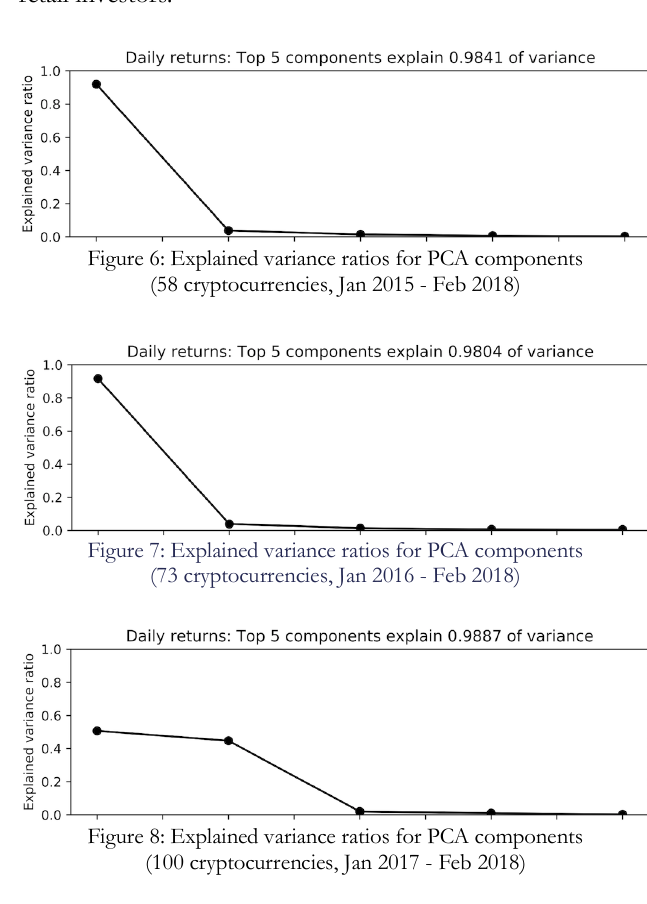
Figure 8: Explained variance ratios for PCA components (100 cryptocurrencies, Jan 2017 - Feb